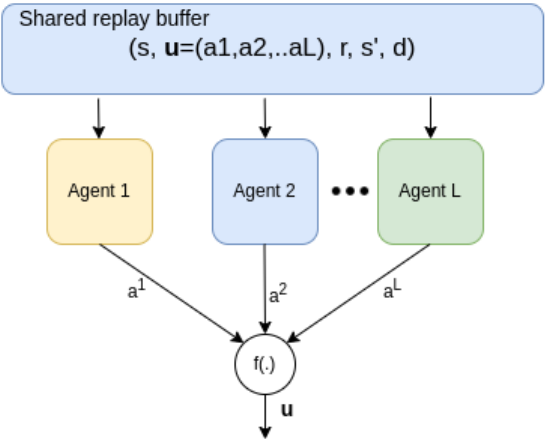
Figure 4. Parallel training and execution. All agents share the replay buffer from which experiences can be sampled in batches and used for training in